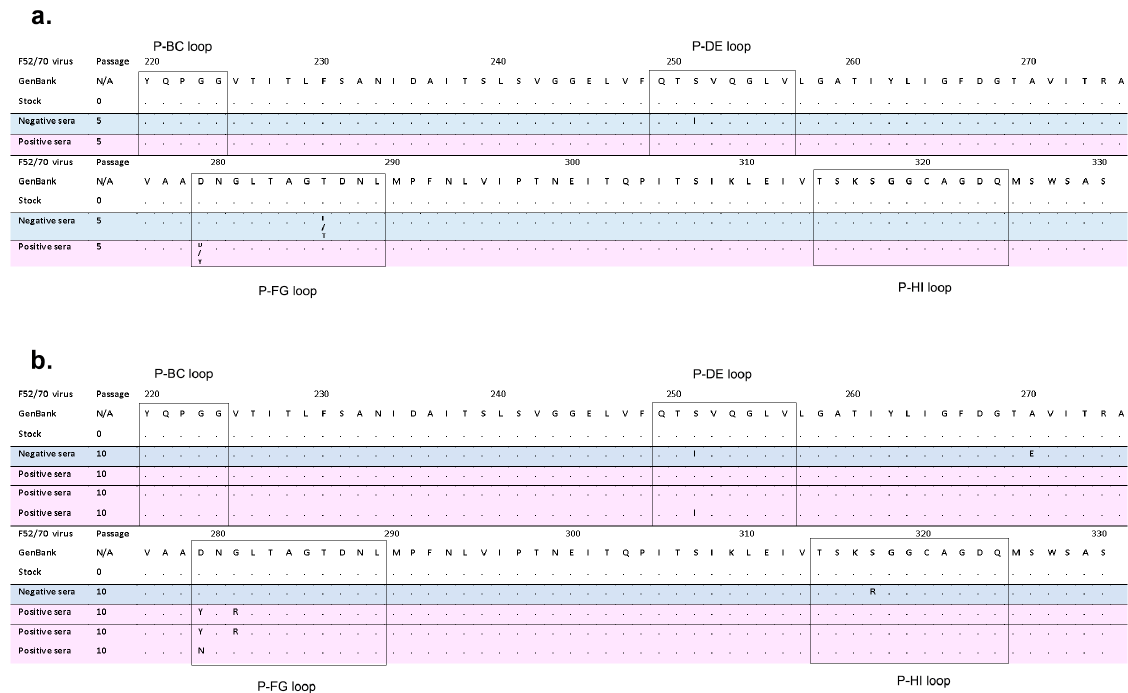
Figure 3. Alignment of the HVR amino acid sequence from IBDV strain F5/70 passaged in positive or negative serum. ( a ) The amino acid sequence of the VP2 HVR of the IBDV strain F52/70 that is in GenBank (Accession number AY321953) was aligned to the following sequences: the stock F52/70 virus at passage (P)0, the F52/70 virus that had been passaged 5 times in negative serum lacking anti-IBDV antibodies (Negative sera) (blue shading), and the F52/70 that had been passaged 5 times in increasing concentrations of anti-2512 serum (Positive sera) (pink shading). ( b ) The F52/70 GenBank sequence was aligned to the stock F52/70 virus at P0, the F52/70 virus at P10 in Negative sera (blue shading), and the three independently generated escape mutants comprised of the F52/70 virus at P10 in Positive serum (pink shading). Amino acids that were identical to the F52/70 GenBank sequence were labelled with a dot, and amino acids that were different from F52/70 were assigned their lettered code. The four hydrophilic loops within the HVR (loops P-BC, P-DE, P-FG, and P-HI) were